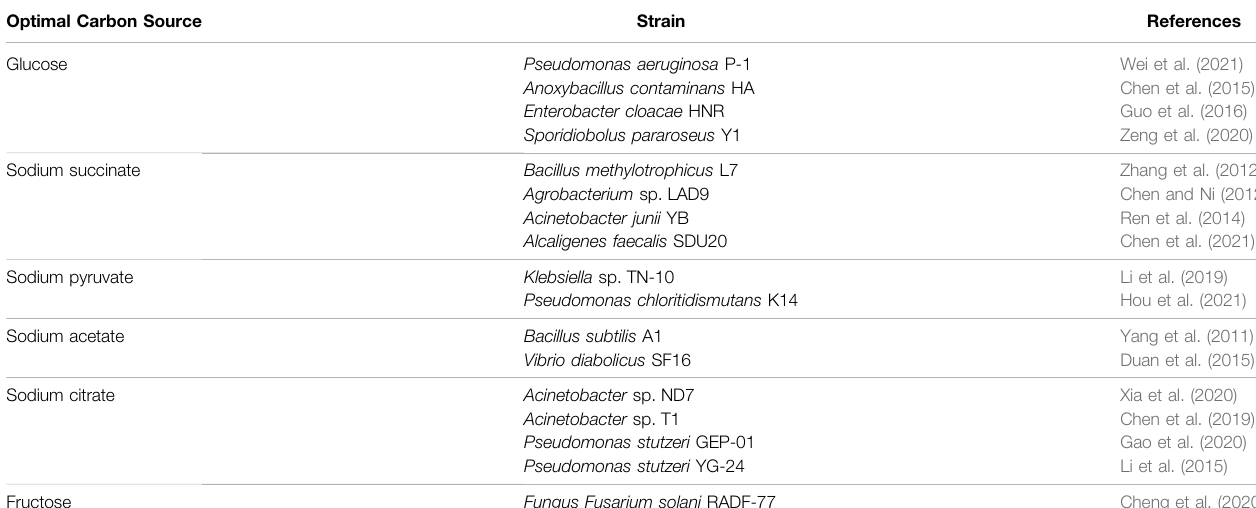
TABLE 3 | Optimal carbon sources for